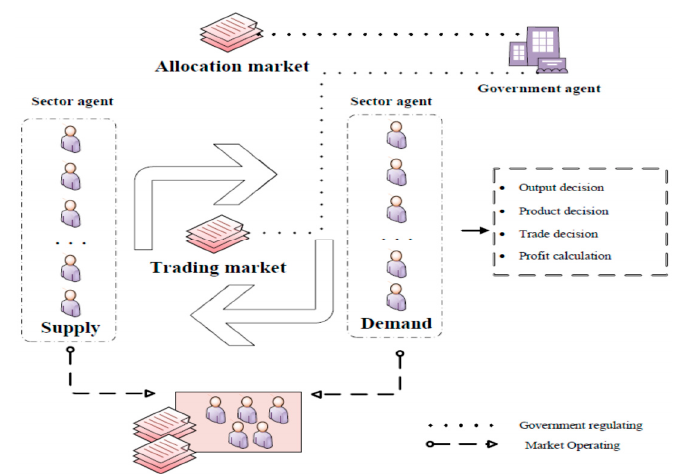
Figure 1. Framework of agents and markets.